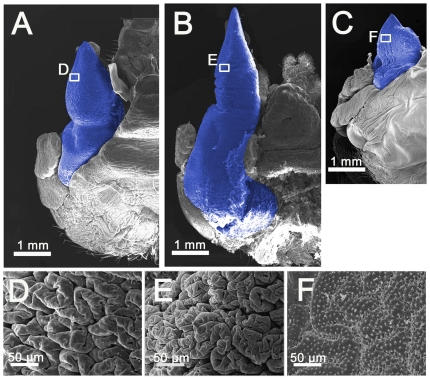
SEMs of the newly-formed stag beetle mandibles dissected from the prepupal cuticle immediately before pupation.(A–C) SEMs of the left side of newly-formed stag beetle heads and mandibles. (A) Small male, (B) large male, (C) female. Mandibles are indicated in blue. (D–F) Magnified images of the mandibular regions indicated by the white boxes in A, B, and C. The surface structures of the mandibles are different among the three types of individuals.